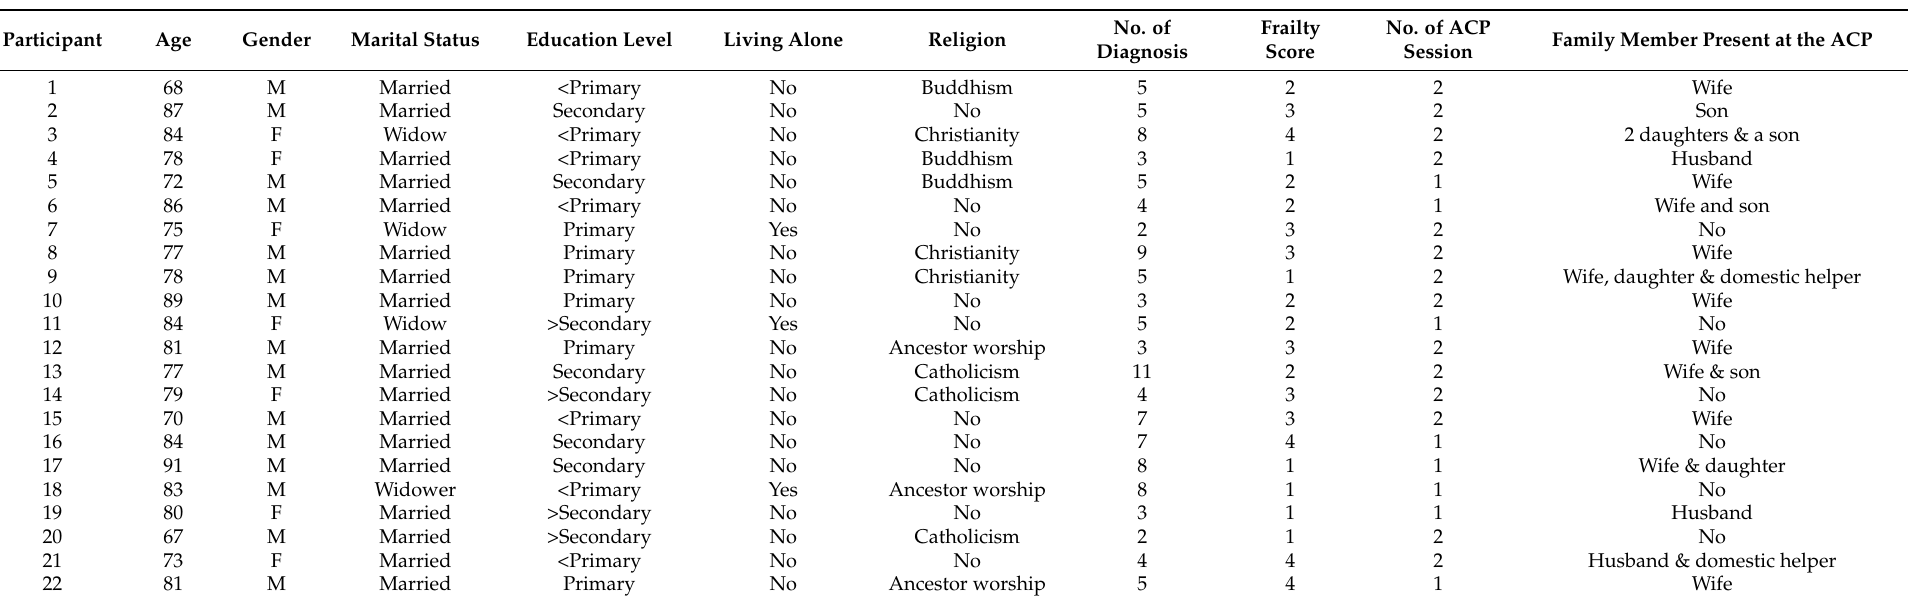
Table 1. Socio-demographic, clinical characteristics and participation in ACP conversation of the participants (N =